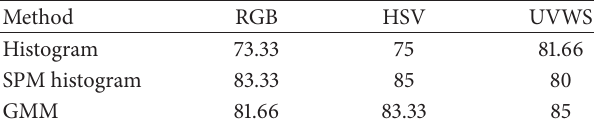
Table 2: The average precision for persons retrieval in location